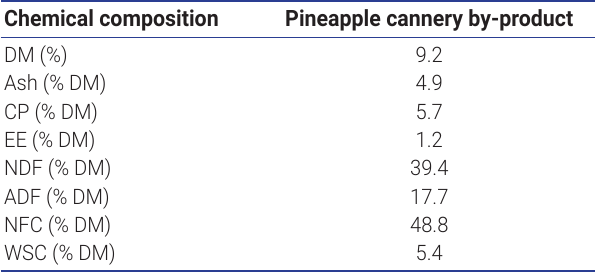
Table 1. Chemical composition of pineapple cannery by-product Chemical composition Pineapple cannery